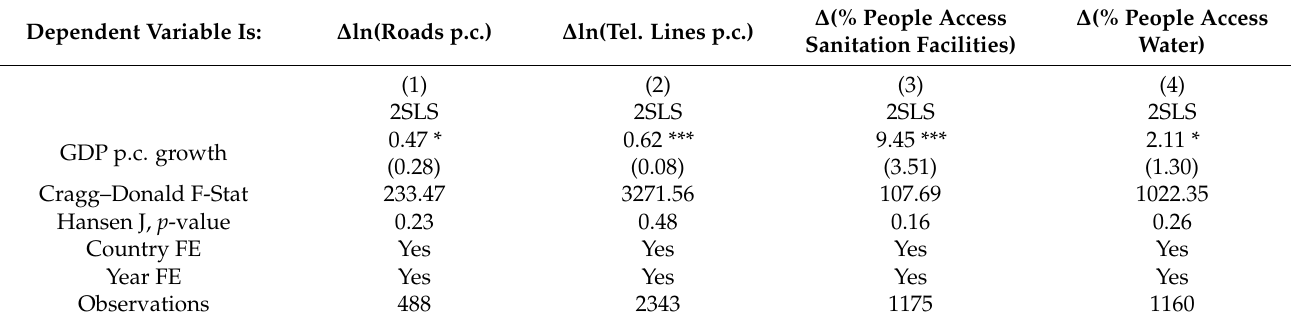
Table 5. GDP growth and infrastructure (overidentified 2SLS